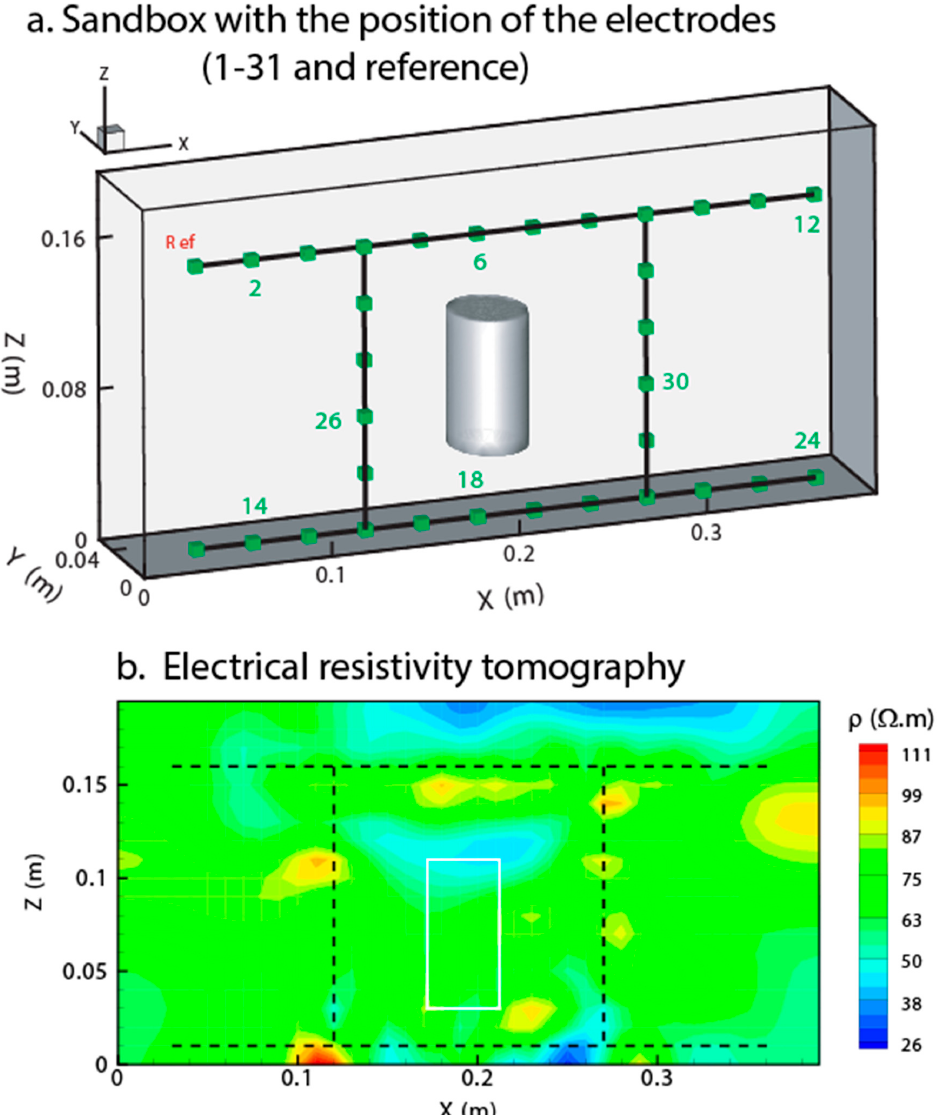
Figure 23. Treasure hunt in a sandbox. The goal of this test is to see which of resistivity or induced polarization tomography performs better to localize the ore in the sandbox without prior knowledge of its position ( a ) Sandbox with the position of the electrodes and the cylindrical area in which the pyrite is located. For each acquisition, we inject and retrieve the current using two electrodes A and B and all the other electrodes are voltage electrodes M i with respect to a reference electrode N = 1 (Ref, see Figure 23). ( b ) Electrical resistivity tomography. The area encapsulated by the white line corresponds to the true position of the target (pyrite grains mixed with sand). The resistivity tomography is unable to show up the position of the ores because the effect of the ores has only a minor effect on the DC conductivity of the mixture. The induced polarization tomography is shown in Figure 24.